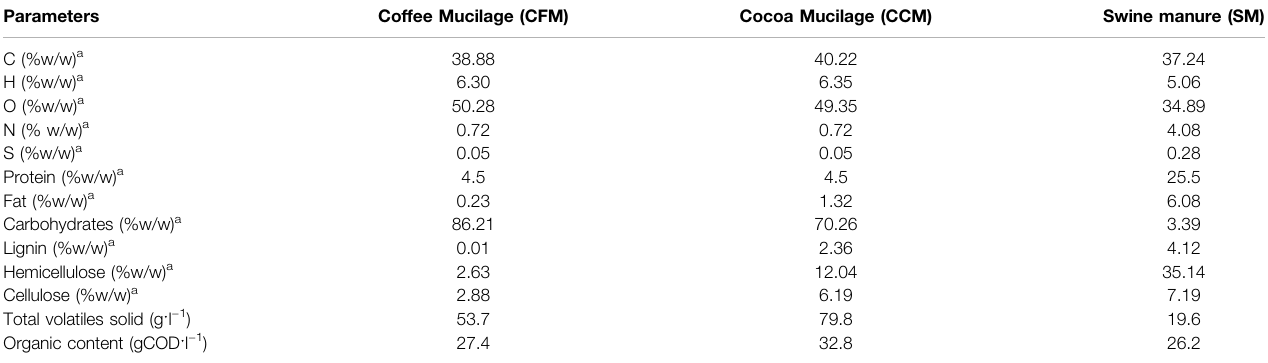
TABLE 1 | Composition of coffee mucilage, cocoa mucilage, and swine manure. Parameters Coffee Mucilage (CFM)